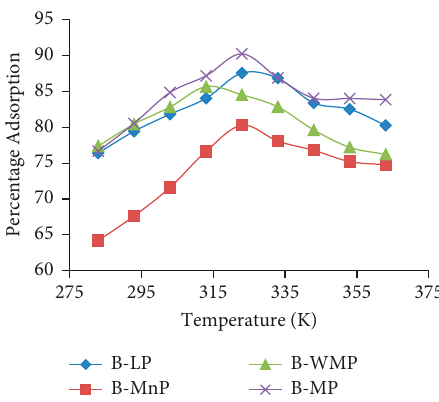
Figure 8: Effect of temperature on the sorption of Cr (VI) on different sorbents. Table 3: Langmuir isotherm for Cr (VI) removal by base-treated sorbents.